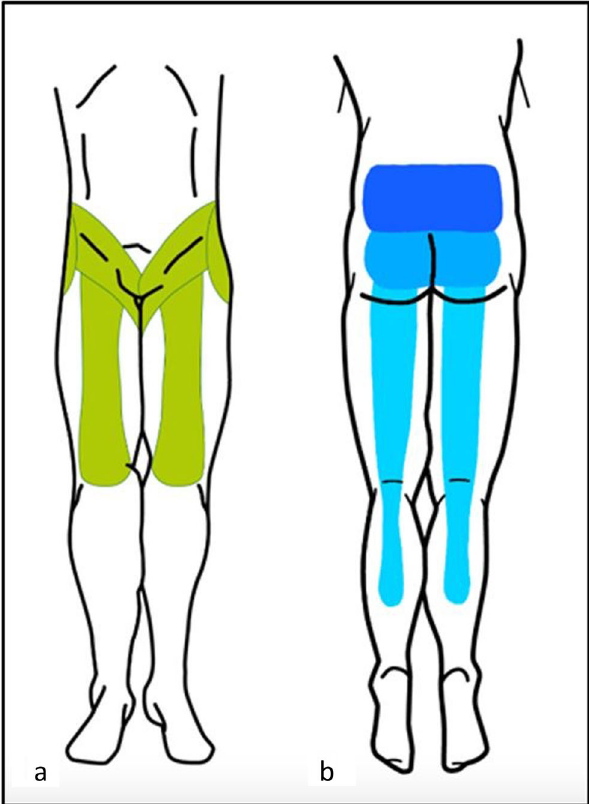
Fig. 5 Facet joint pain radiation . Posterior aspect of lower limb. Blue: from most frequent (dark blue), to less frequent (light blue) radiating pain areas. Dark blue: pain limited to lower back. Intermediate blue: radiating pain to the posterior aspect of the buttocks. Light blue: radiating pain to the posterior aspect of the lower limbs, may extend lower than the knee level. Green: anterior aspect of lower limb possible radiation areas. a anterior aspect of the lower limb (green). b posterior aspect of the lower limb